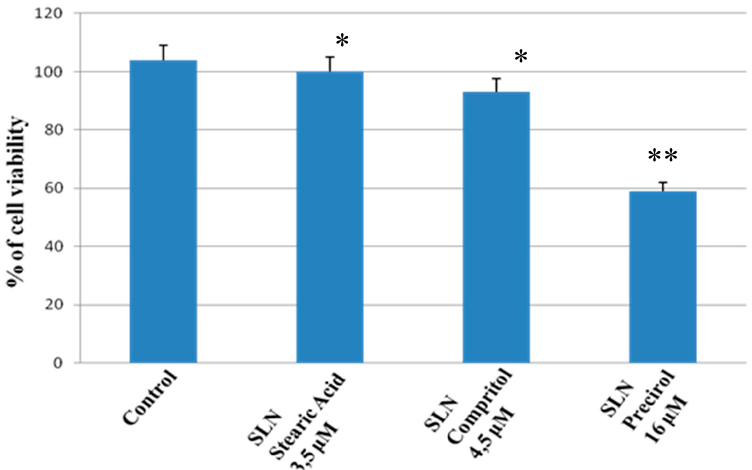
Figure 1. Percentage of viability of primary human Dental Pulp Stem Cell (DPSC) cell cultures exposed to stearic acid (3.5 µM), Compritol (4.5 µM) 888 ATO, and Precirol (16 µM) 5 ATO for 24 h. Results are expressed as the mean ± S.D. of the values of five separated experiments performed in triplicate. **indicate p < 0.05 significant differences vs. control, and * represents p > 0.05 vs. control (untreated cells).